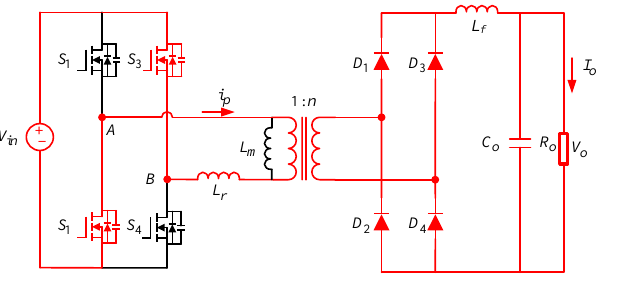
Figure 2. Operation mode during t 0 ~ t 1 .